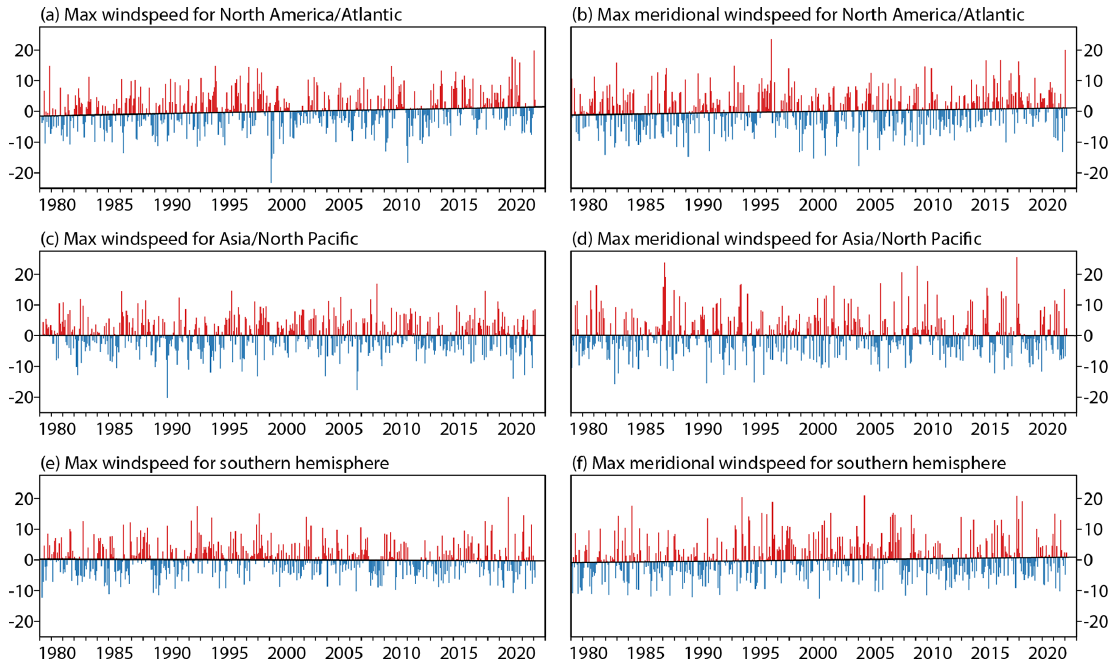
Figure 16. Deviations (ms − 1 ) from average values for each month in the period March 1979 to February 2022 in the highest 200hPa wind speed analysed during the month over regions covering most of (a) North America and the North Atlantic (20–90 ◦ N, 120–20 ◦ W), (c) Asia and the North Pacific (20–90 ◦ N, 60 ◦ E–120 ◦ W), and (e) the Southern Hemisphere south of 20 ◦ S. Panels (b) , (d) and (f) are corresponding time series for the maximum speed of the meridional wind component. Values are plotted according to whether they are above (red) or below (blue) the least squares fit linear trend for the